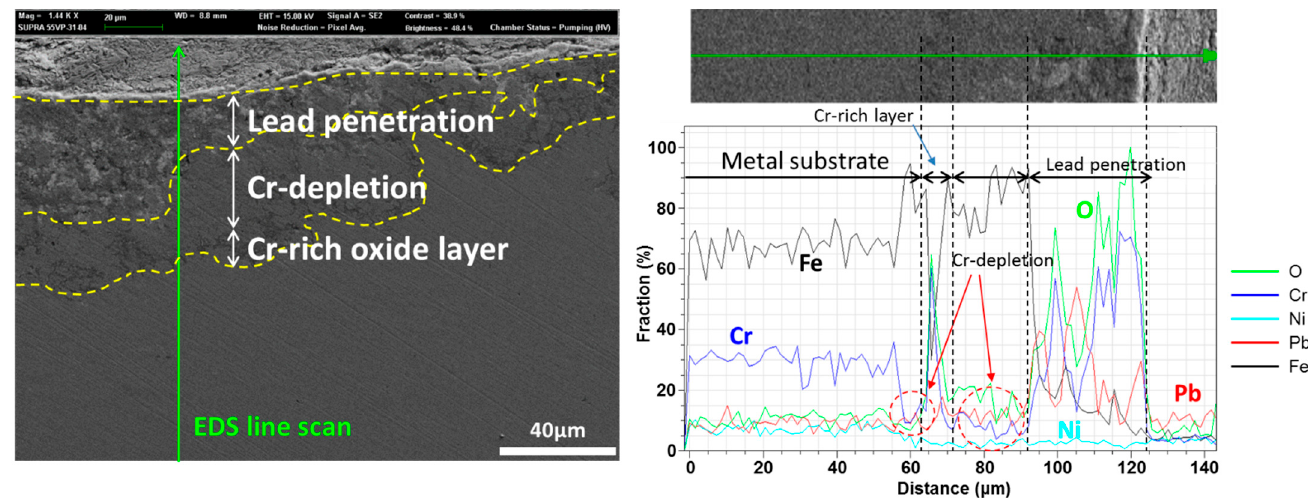
Figure 13. EDS analysis of LBE-penetrated region on SS316L in Cr-depleted and inner Cr-rich reformed oxide regions after 2000 h at 600 °C.